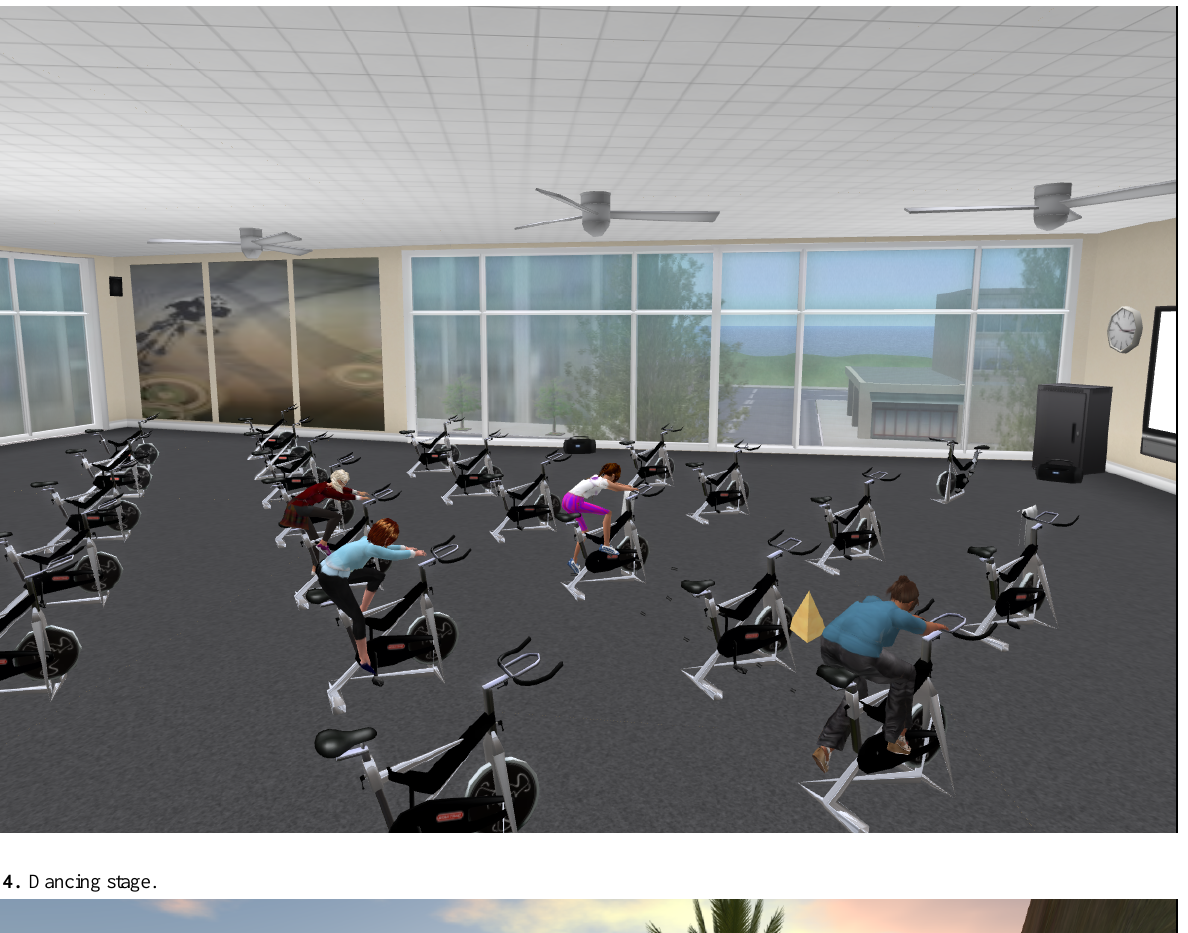
Figure 4. Dancing